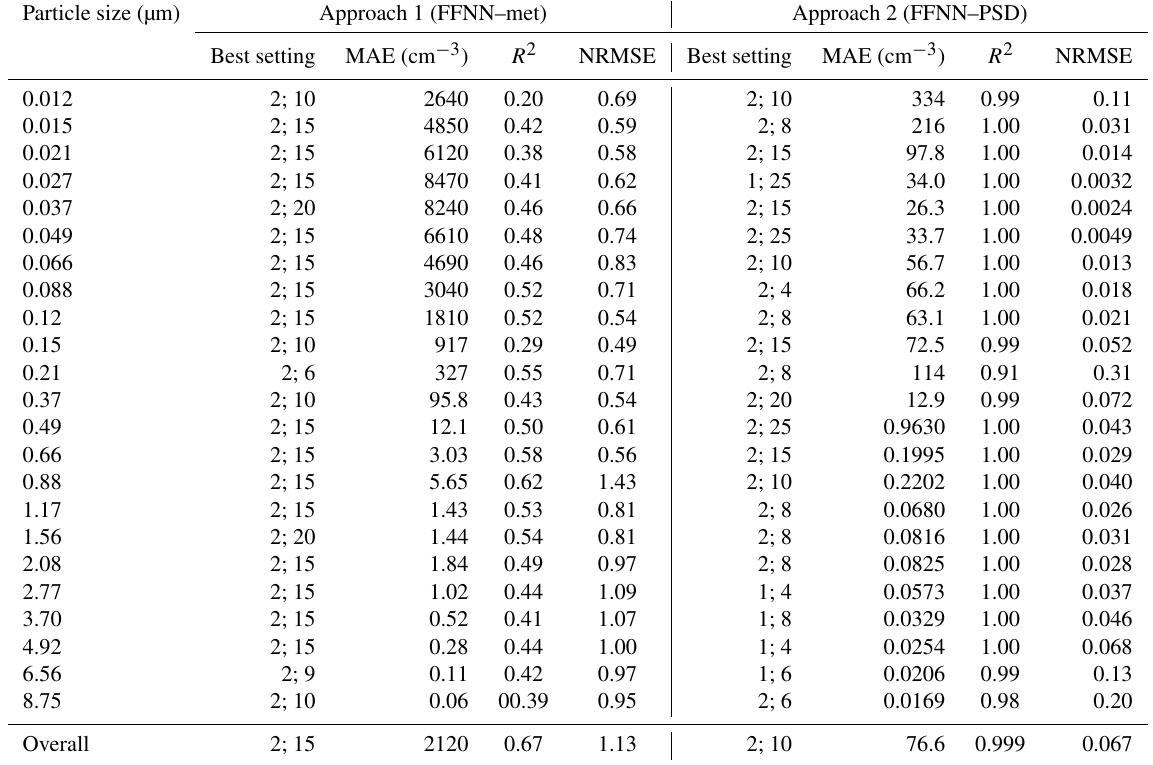
Table 2. Table showing the best configuration in the form of (the number of layers; the number of neurons) for the approach by meteorological parameters (FFNN–met) and the number concentration at the other size bins (FFNN–PSD) as inputs. Mean absolution error (MAE, in cm − 3 ), coefficient of determination ( R 2 ) and normalised root-mean-square error (NRMSE) are listed for different size bins on each row. The last row concludes the overall selection of the approach with the best configuration and its corresponding evaluation